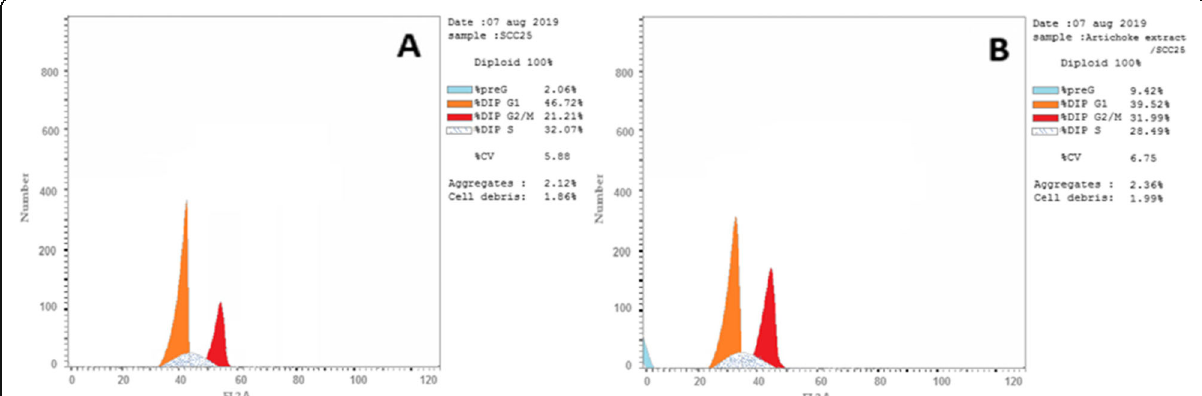
Fig. 5 Artichoke extract induces cell cycle arrest in SCC-25 cell lines. Flow cytometric analysis was performed for cell cycle distribution. The DNA content was evaluated with PI staining, fluorescence measured, and analyzed. Representative flow cytometry graph for untreated control SCC-25 group ( a ) and artichoke-treated SCC-25 group ( b )